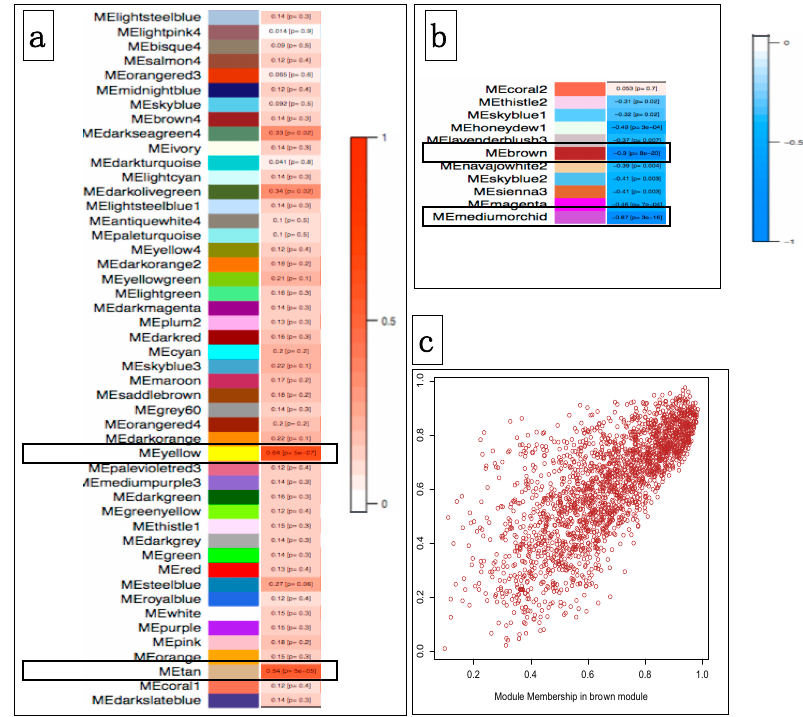
Figure 4. Module–trait associations. ( a ) Each row corresponds to a ME (module eigengene), and the column to the mucosal melanoma trait. Each cell contains the corresponding correlation and p -value with melanoma. Each correlation is color-coded according to the strength of the correlation, with a red gradient for positive correlations (red bar in 4.a). Modules Yellow and Tan are positively correlated ( p < 5 × 10 − 5 ). ( b ) Modules with negative correlations according to the strength of the correlation; (blue bar in 4.b). Module Brown and Medium-orchid are the most significantly negatively correlated ( p < 1 × 10 − 16 ). ( c ) Scatterplot of gene significance for mucosal melanoma status vs module membership for the Brown module. It shows a highly significant correlation between gene significance and Module membership in this module.